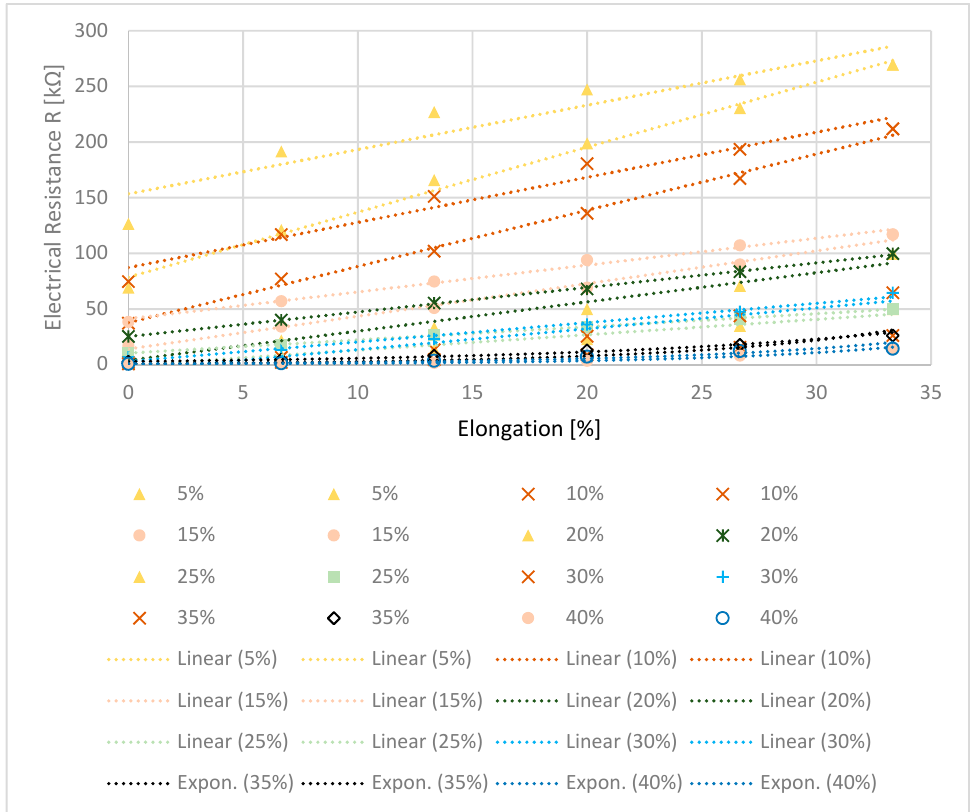
Figure 9. Electrical Resistance as function of elongation for different concentrations of Ag352000. The lower curve belongs to stress, the upper curve belongs to release of the monofilament.